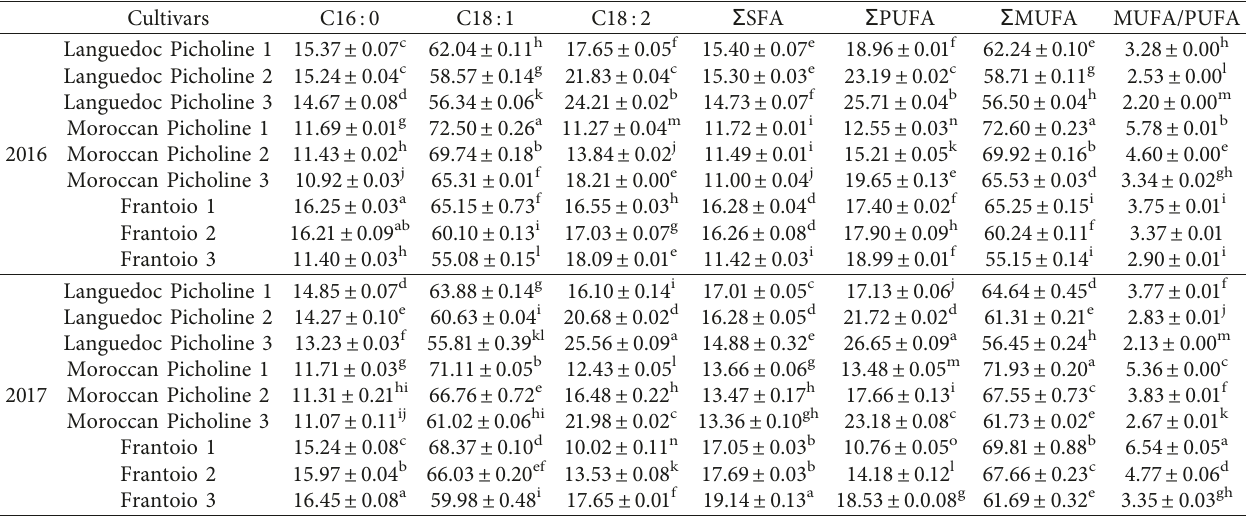
SFA:saturatedfattyacid;MUFA:monounsaturatedfattyacid;PUFA:polyunsaturatedfattyacid. ∗ Eachvalueisanaverageofthreedeterminations,andvalues in the same row with different letters show statistically significant differences ( P < 0 . 05). Table 6: Fatty acid composition (%) of the virgin olive oils of three cultivars grown in Marrakech (Morocco) during the two crop seasons (2016 and